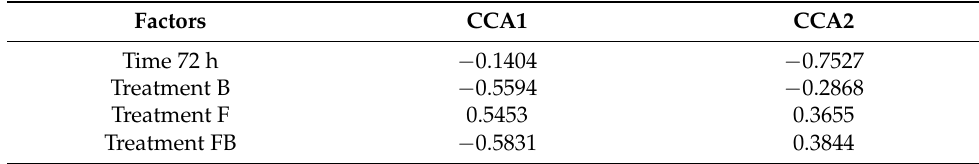
Table 4. Biplot scores for constraining